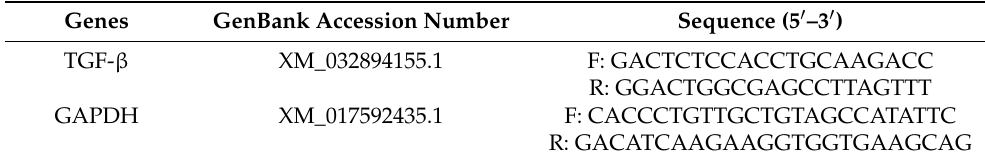
Table 2. Primer sequences for rats.